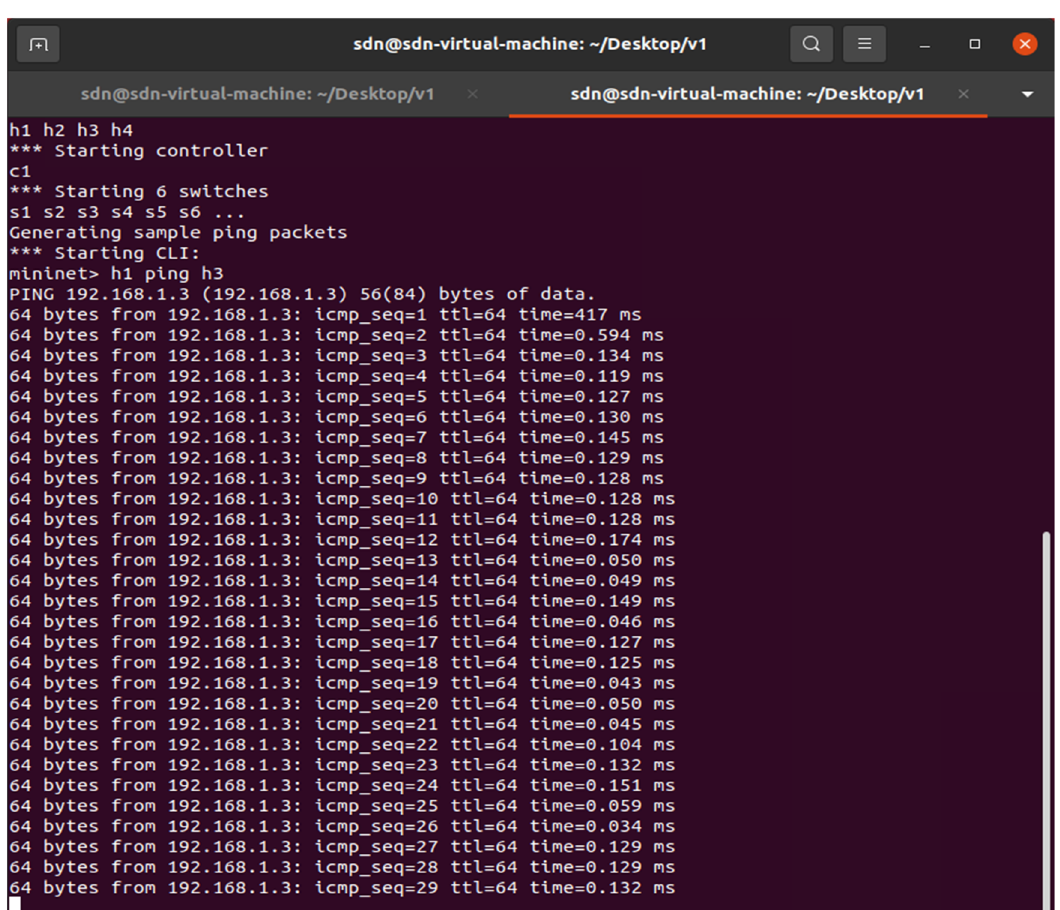
Figure 6: Ping from host 1 to host